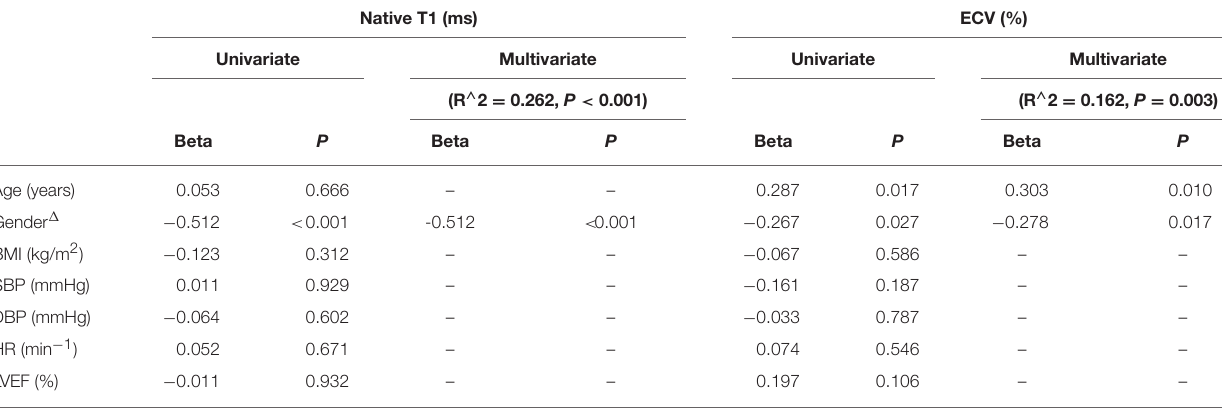
TABLE 3 | Linear regression analysis of global native T1 and ECV.